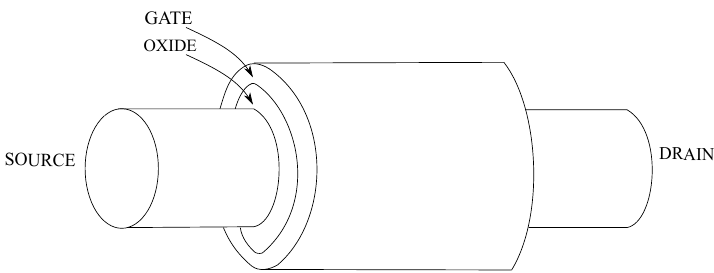
Figure 5. Three-dimensional (3D) structure of a cylindrical junctionless GAAFET.